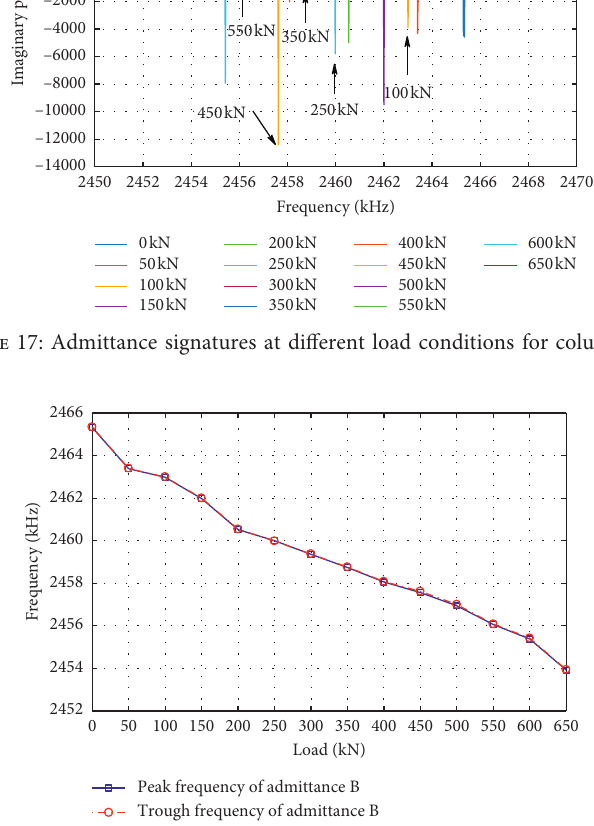
Figure 18: Frequencies corresponding to the peak and trough of the admittance signature for specimen